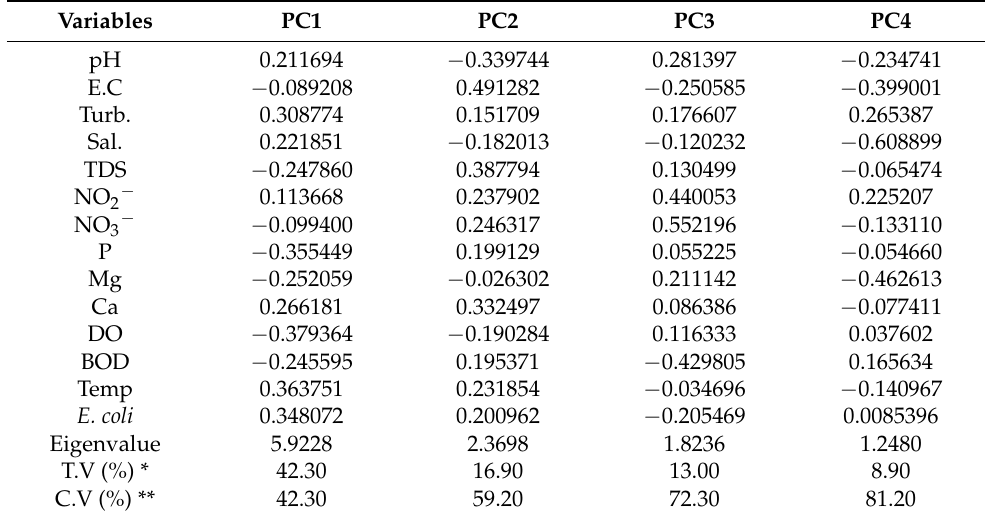
Table 5. Loadings of the variables for the first four principal